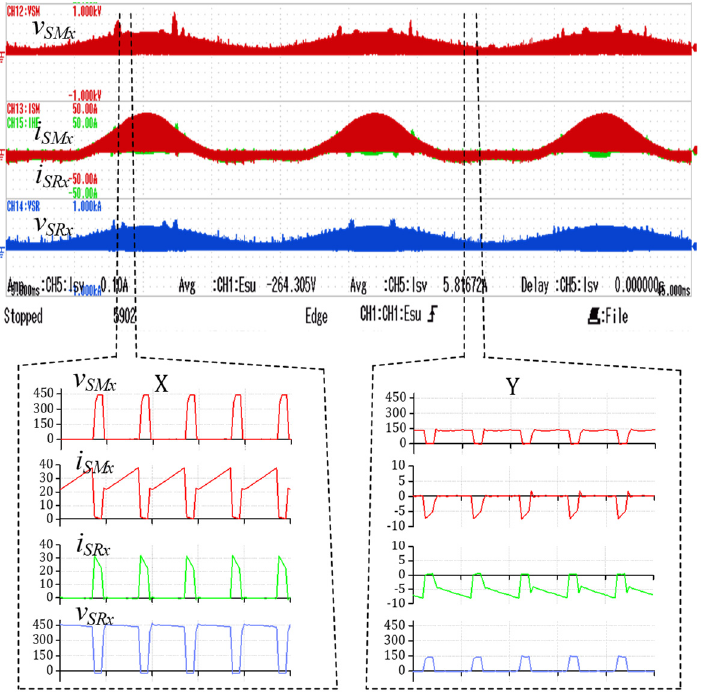
Figure 9. Experimental high-frequency switched waveforms of the proposed IFBI with SOHC compensation at 1.6 kW.